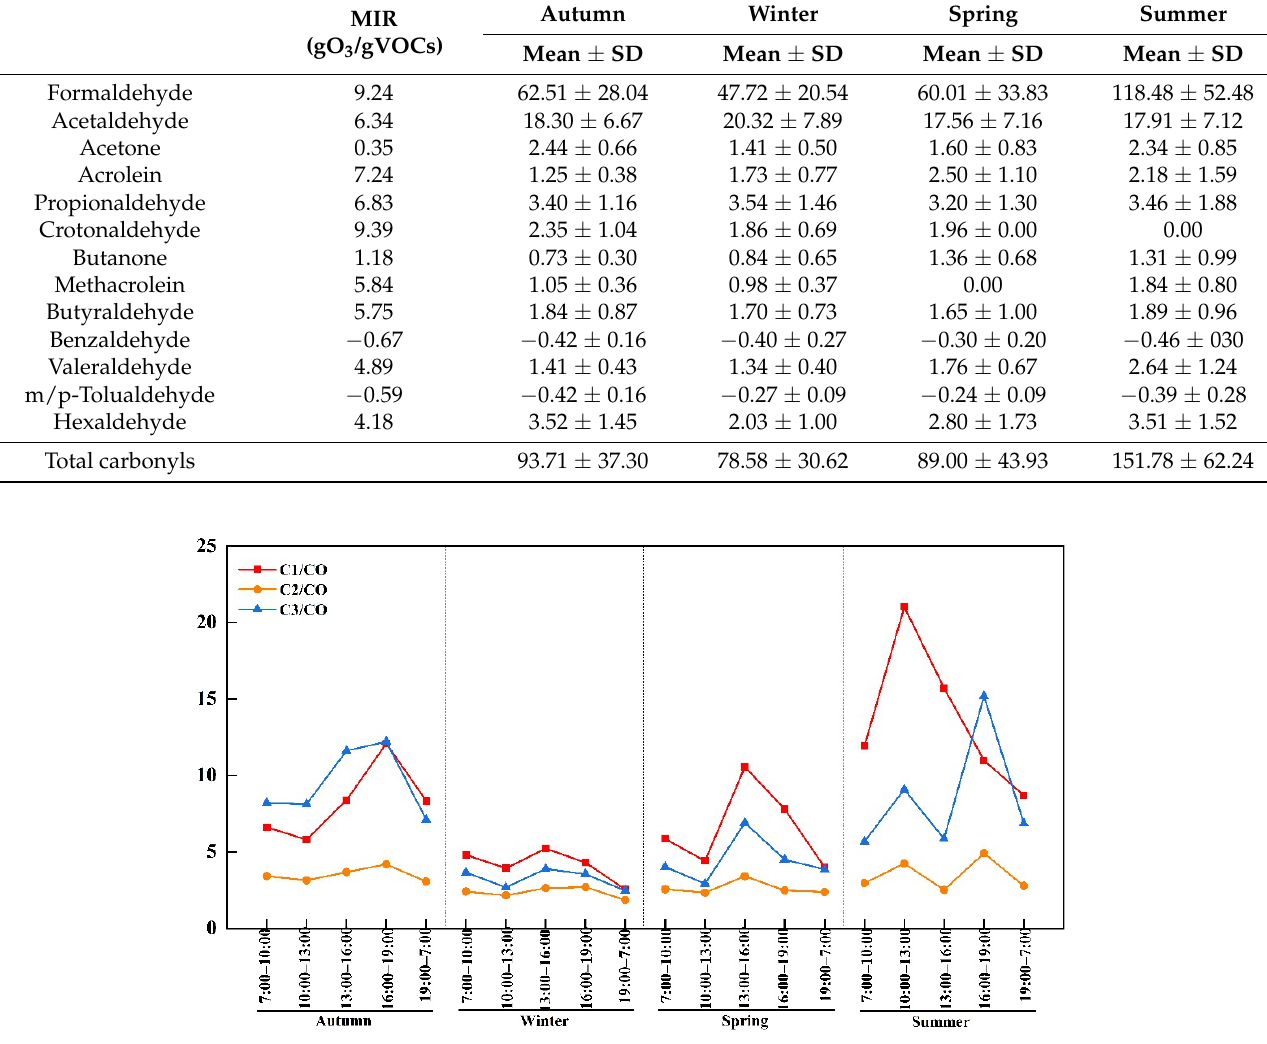
Figure A3. The wind direction weighted carbonyls concentrations in summer. References 1.